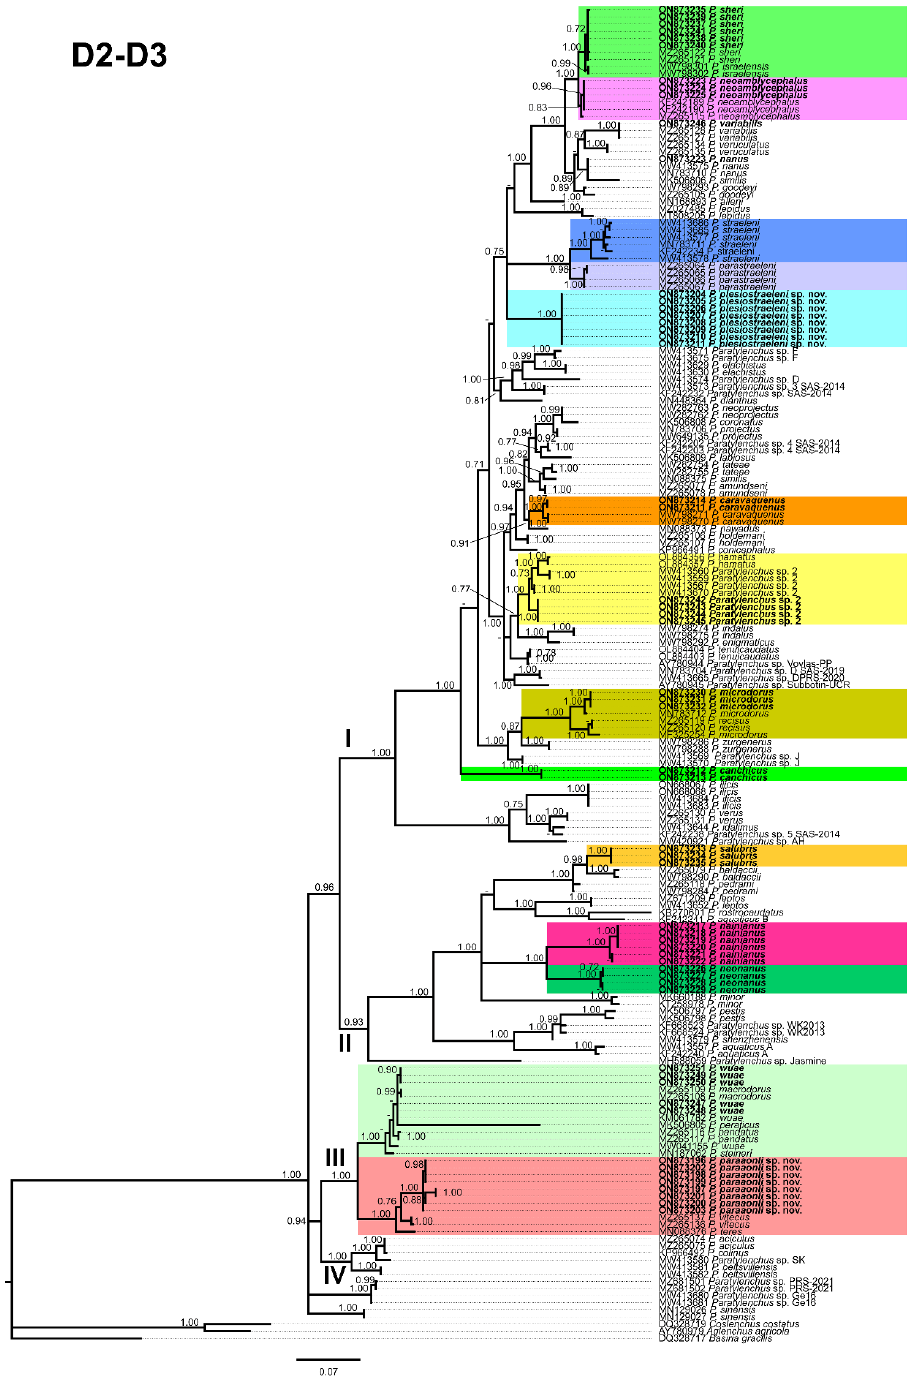
Figure 14. Phylogenetic relationships within the genus Paratylenchus . Bayesian 50% majority rule consensus tree as completed from D2-D3 expansion domains of the 28S rRNA sequence alignment under the general time-reversible model with invariable sites and gamma distribution model (GTR + I + G). Posterior probabilities of more than 0.70 are given for appropriate clades. Newly obtained sequences in this study are shown in bold. The scale bar indicates expected changes per site, and the colored boxes indicate the clade association of new Paratylenchus species sequenced in this